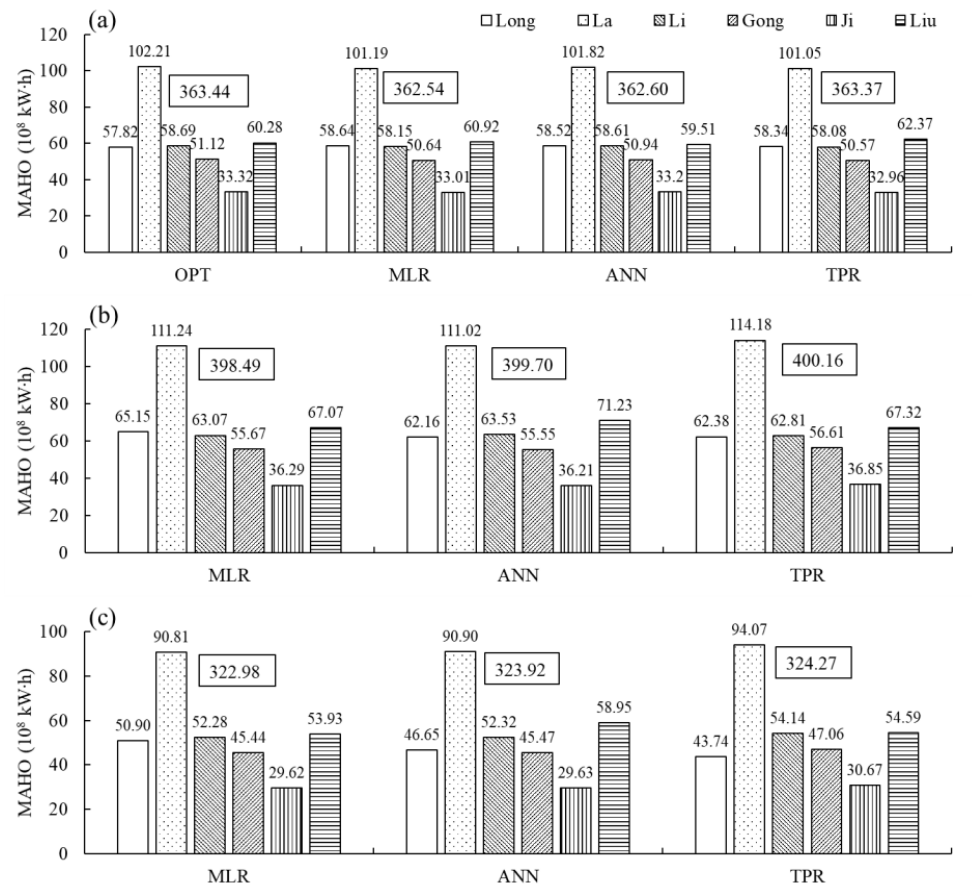
Figure 8. MAHOs of six hydropower reservoirs in the UYR multireservoir system under different inflow conditions (Note: ( a ) denotes the historical inflow condition; ( b , c ) represents the increased/reduced inflow condition; and the number in the box denotes the MAHO of the UYR multireservoir system).